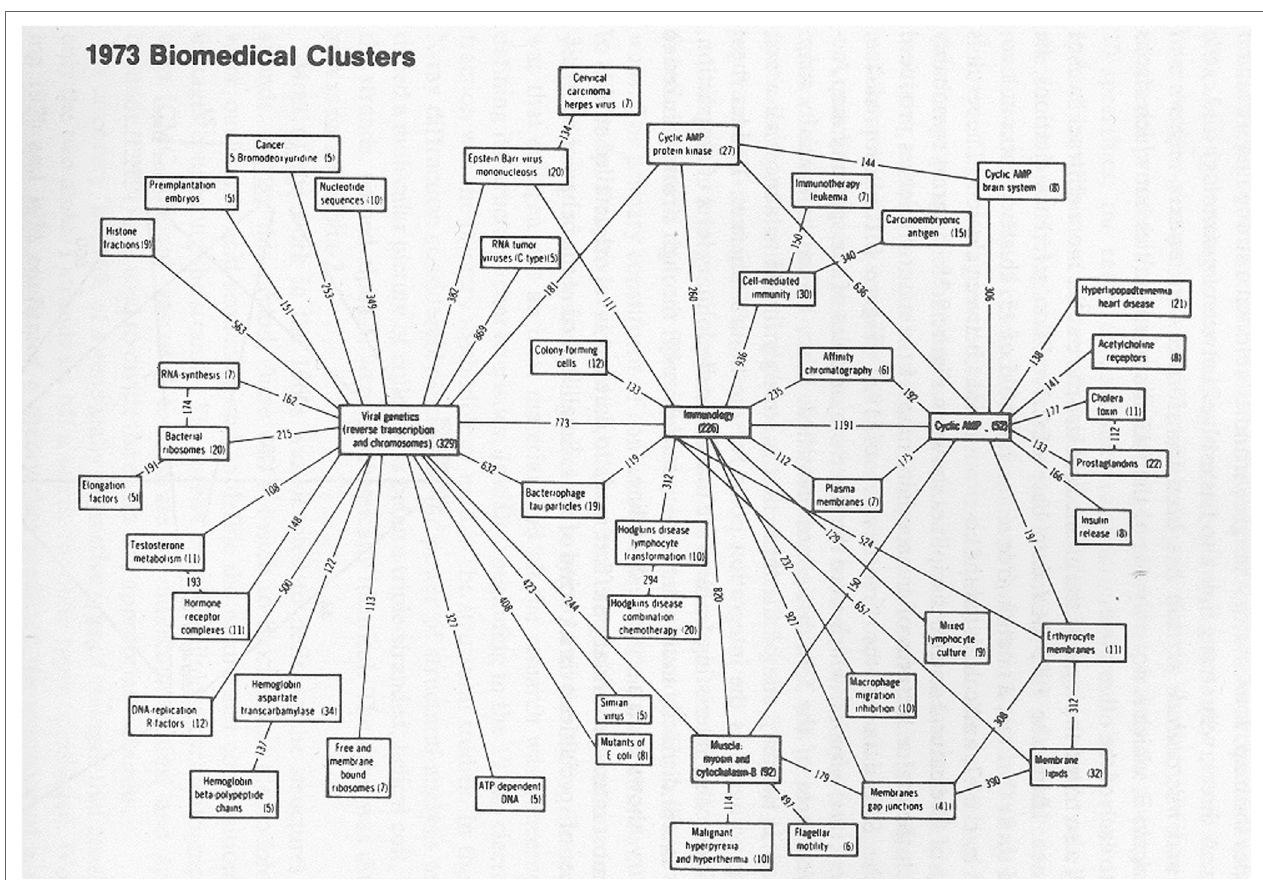
FiGuRe 2 | Map of 1973 biomedical clusters. Boxes represent clusters. Parenthetical numbers in boxes indicate the number of cluster documents. Co-citation links between clusters are shown by connecting lines; strength of links is shown by numbers in lines. Reprinted from Garfield (1979) (p. 121), with permission of the Eugene Garfield